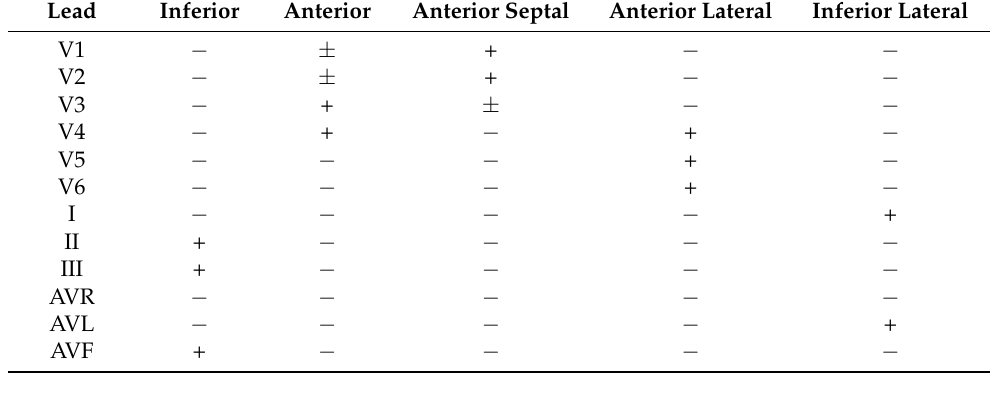
Table 2. Electrocardiographic diagnosis of myocardial infarction.